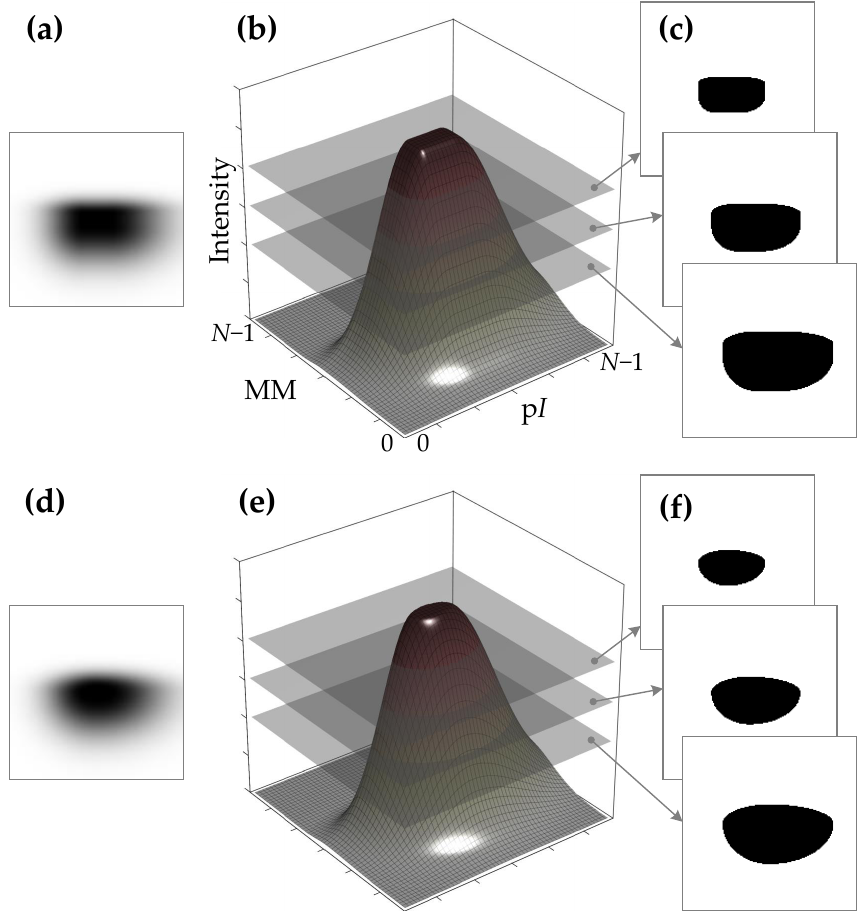
Figure 2. Results of the two approaches to generating the synthetic protein spot: by the outer product of two vectors that correspond to the vertical and horizontal sections of the spot ( a – c ) and by elliptical interpolation of the vertical and horizontal sections of the spot ( d – f ) as described in the current research. The approaches reside at different sides of the speed–fidelity scale. A faster construction of the spot leaves some undesirable artifacts in the spot appearance ( a – c ). In cases when generating more extremely saturated spots (spots with larger plateaus on the top), the horizontal sections of the spots start to lose smoothness ( c ). When the process of spot shape construction is not constrained by the time limits, a more computationally intensive approach allows for generating smoother saturated spots ( d – f